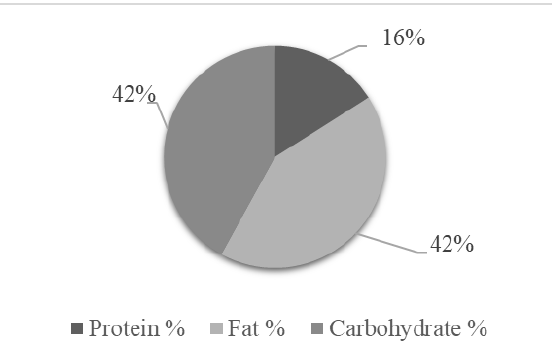
Figure 2. Percent energy from macronutrients in the study population of patients with type I Gaucher disease (total energy intake 2091 kcal/day).